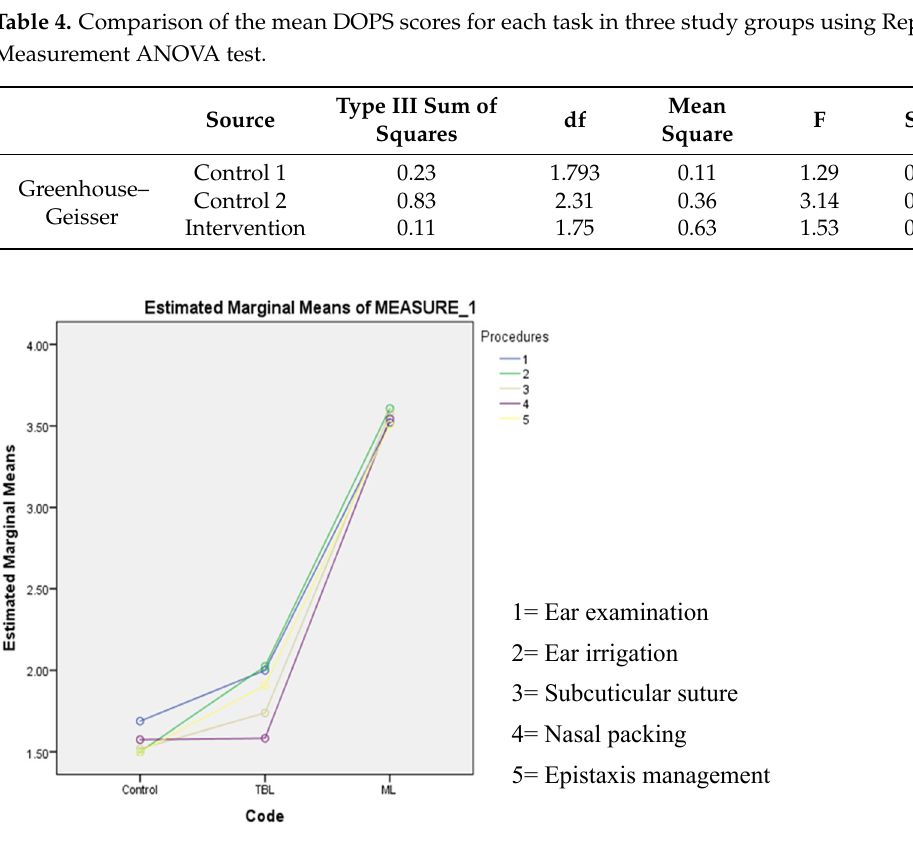
Figure 1. The result of Repeated Measurement ANOVA test for comparing the mean DOPS scores for each task in three study groups.